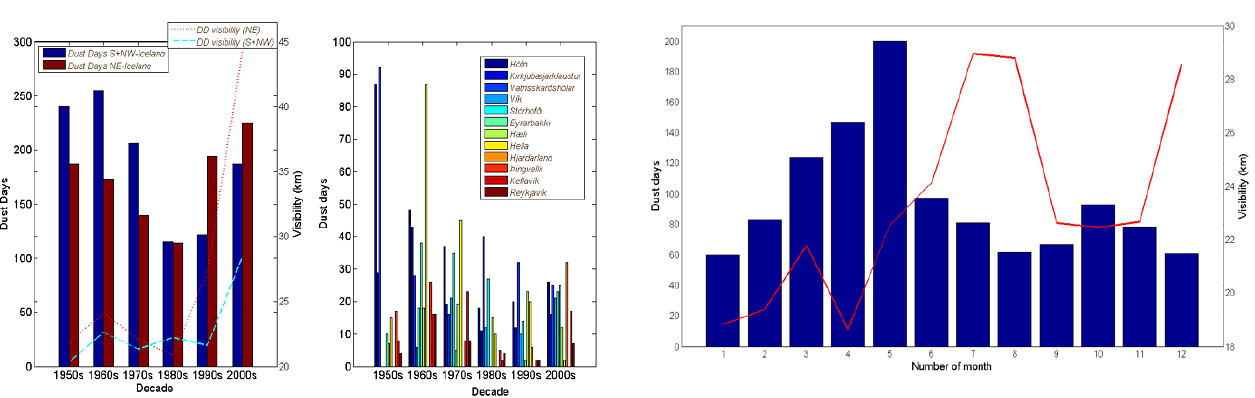
Figure 2. Left panel: total number of dust days, all stations com- bined (blue bars for southern and northwestern Iceland, brown bars for northeastern Iceland). Lines represent mean visibility (blue for S, brown for NE Iceland). Right panel: individual stations in south Iceland sorted by decade.